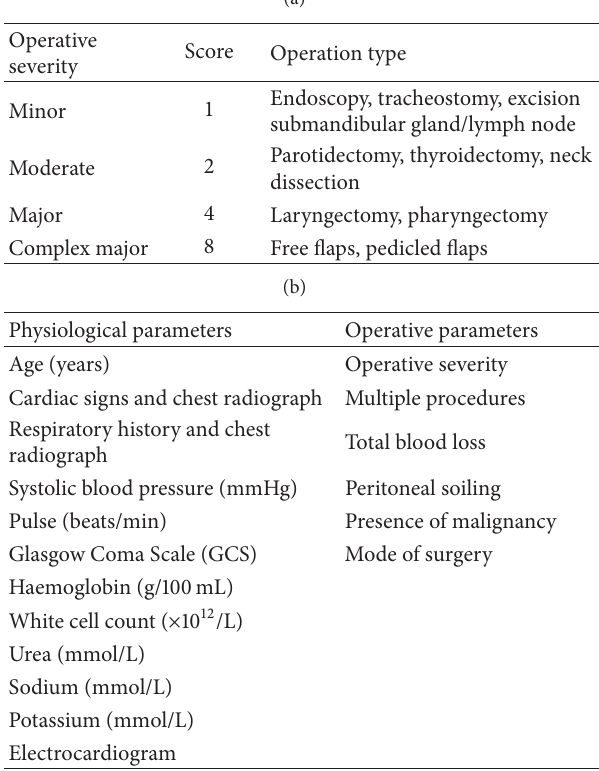
Table 1: (a) Operative severity scoring (adapted from Griffiths et